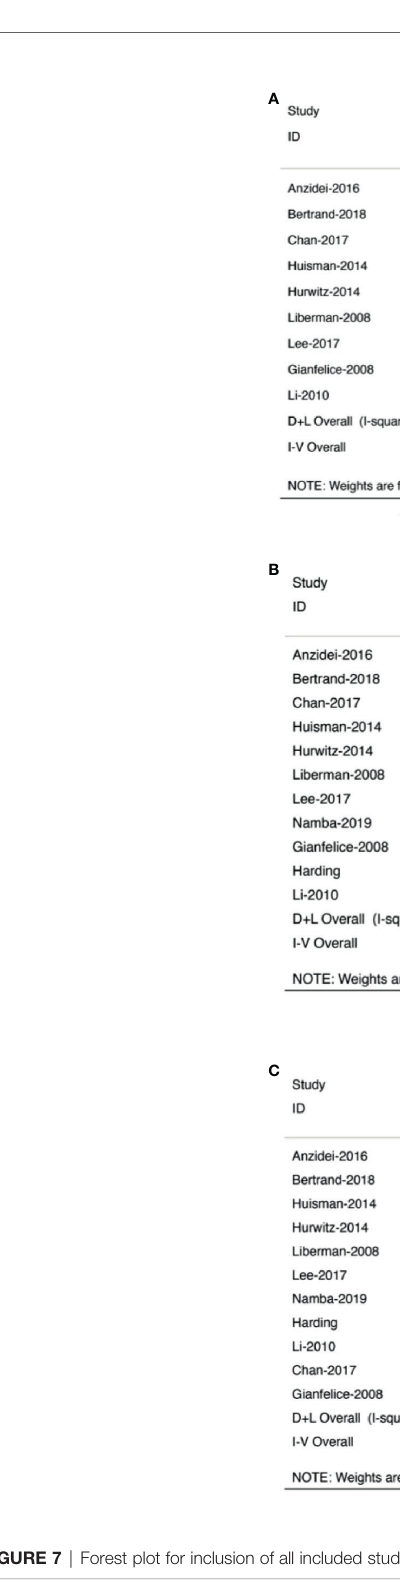
FIGURE 7 | Forest plot for inclusion of all included studies of response rate. (A) Complete response rate. (B) Partial response rate. (C) No response